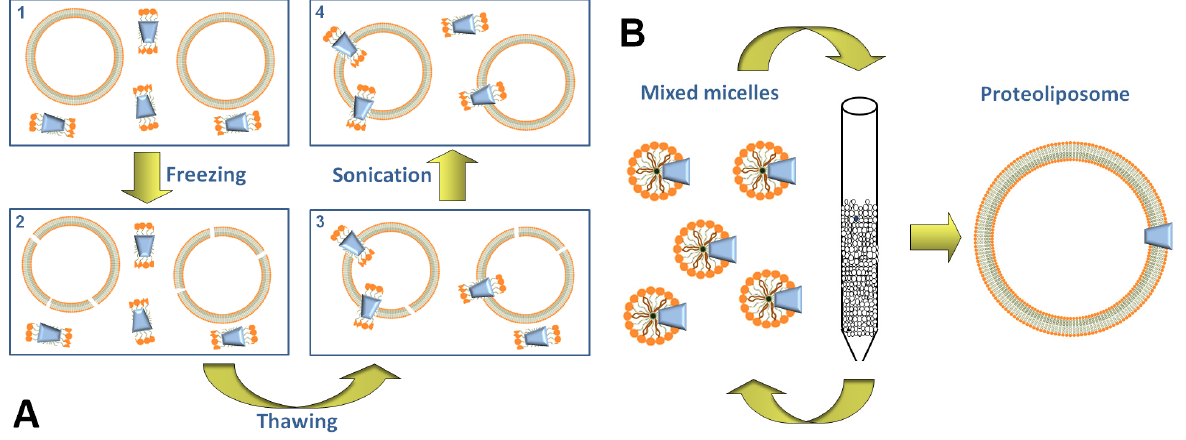
Figure 2. Sketch of methodologies for proteoliposome preparation. ( A ) the four steps of freeze-thaw sonication: ( 1 ) mixture of preformed liposome with protein and detergent; ( 2 ) freezing of the mixture in liquid N with consequent rupture of vesicle membranes; 2 ( 3 ) slow thawing at 0 °C causing the insertion of the protein, solubilized in detergent, into the membrane; ( 4 ) mild sonication step (low energy in pulse mode) which facilitates the sealing of proteoliposomes; ( B ) cyclic chromatography on column: mixed micelles of detergent, phospholipids and protein are shown; detergents and phospholipids are represented by an orange hydrophilic head and one or two carbon chains, respectively. The reconstitution mixture is passed through a column containing hydrophobic resin (Bio-Beads), for 10–20 times. This led to detergent removal with formation of liposomes containing the protein into the membrane bilayer